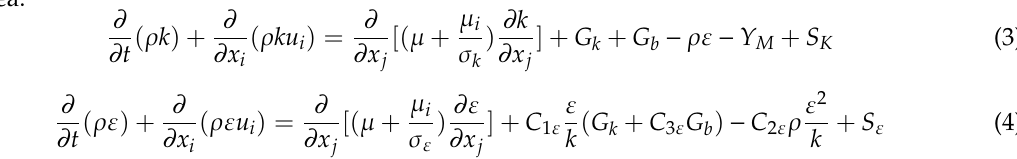
Figure 7. Displacement curve of the exhaust valve.